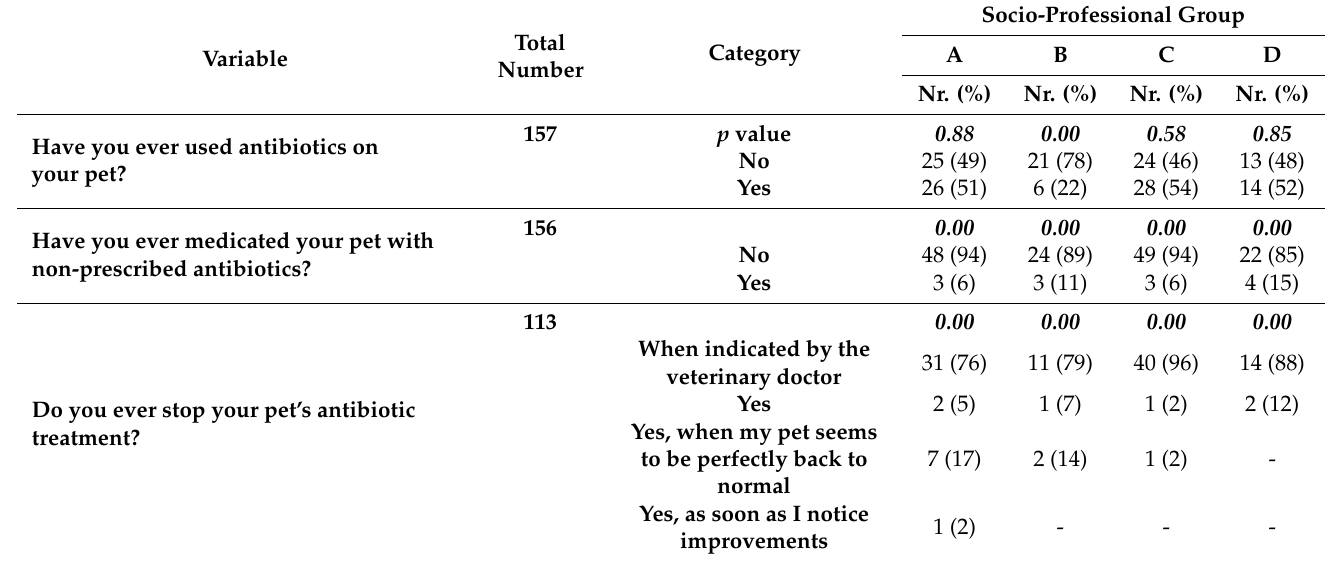
Table 5. Proportions of specific knowledge and experience of the use of antibiotics to treat pets by the socio-professional group